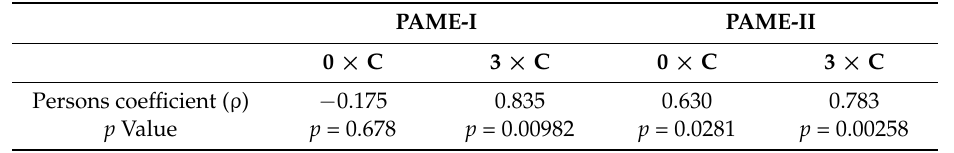
Table 2. Pearson correlation coefficient between ciliate numbers (data from [8]) and viral to prokaryote ratio (VPRs data form Figure 3C,D). 0 × C: no addition of carbon in form of glucose, 3 × C: three Redfield additions of carbon.